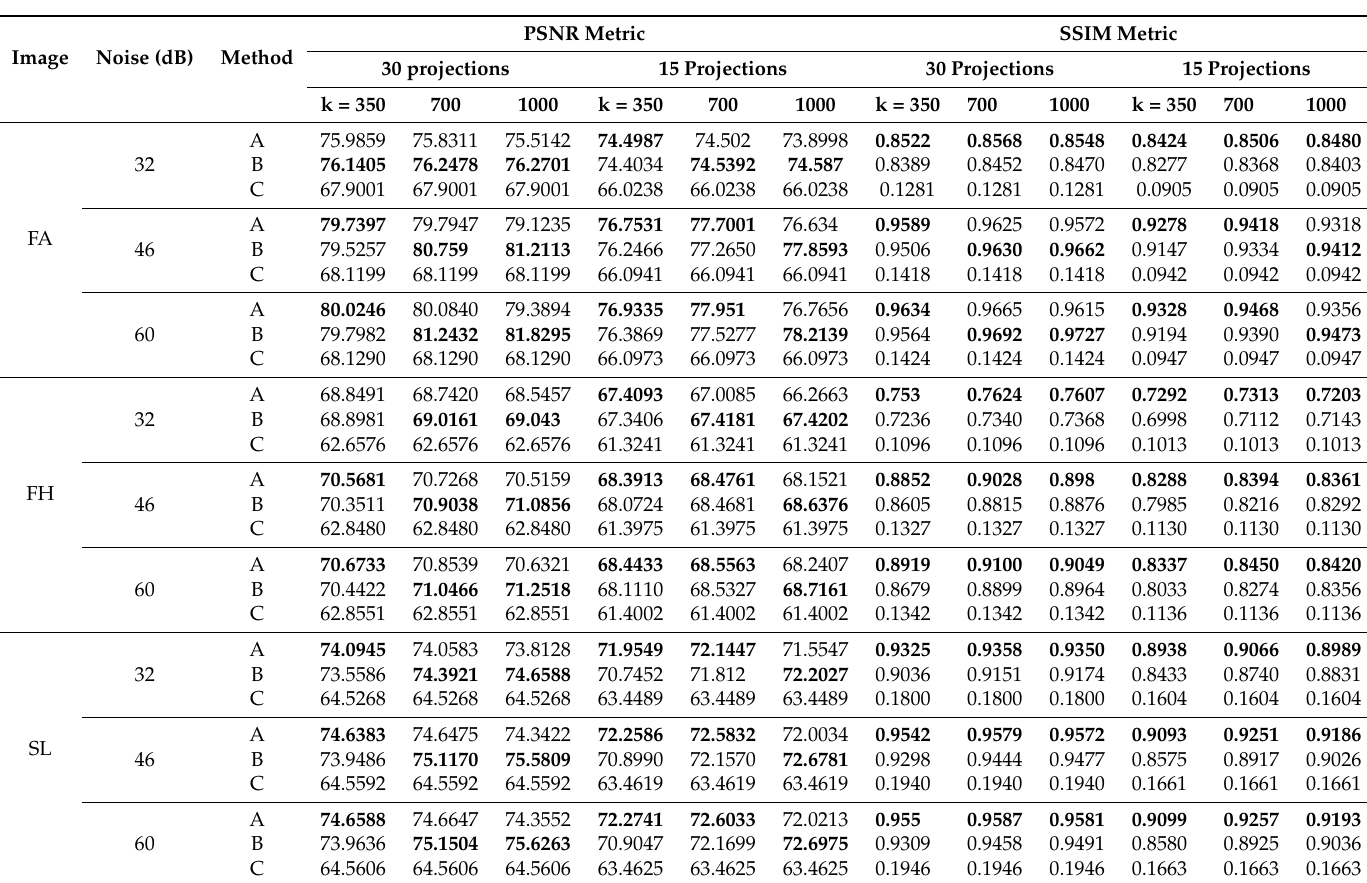
Table 1. Comparison of computer tomography (CT) reconstruction methods A (SART+BEP+DGT), B (SART+DGT), and C (pure SART) for the Shepp–Logan (SL), FORBILD abdomen (FA), and FORBILD head (FH) phantom images using PSNR and SSIM metrics for 15 and 30 projections and signal-to-noise ratio (SNR) of 32, 46, and 60 dB. Each result is the mean of 101 executions of a particular testing case. The values in bold represent the highest value comparing methods A, B and C for each metric (PSNR or SSIM), number of projections (15 or 30) and iterations (350, 700 or